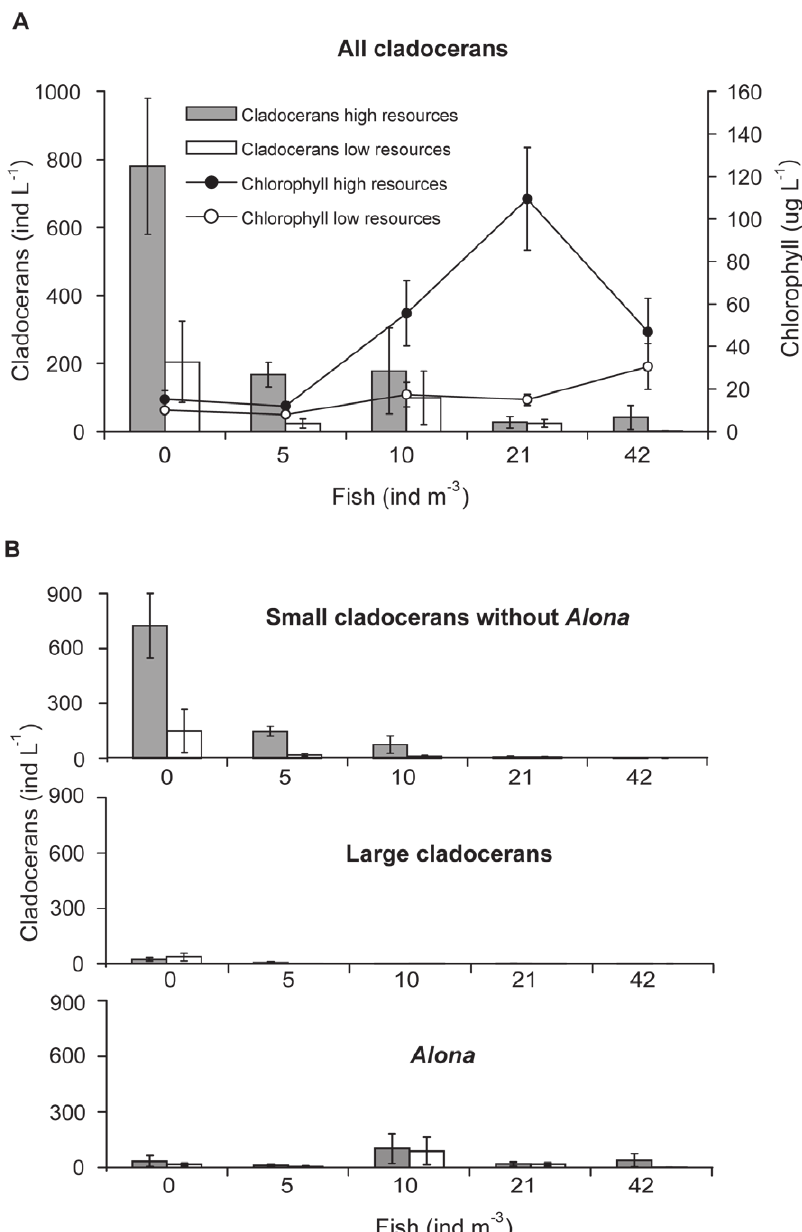
Figure 1. Abundance of zooplankton and chlorophyll- a in treatments with high and low algal resources along the gradient of fish abundance used in the experiment. A : all cladocerans and chlorophyll- a concentrations (means 6 SE over time), B : different cladoceran groups.